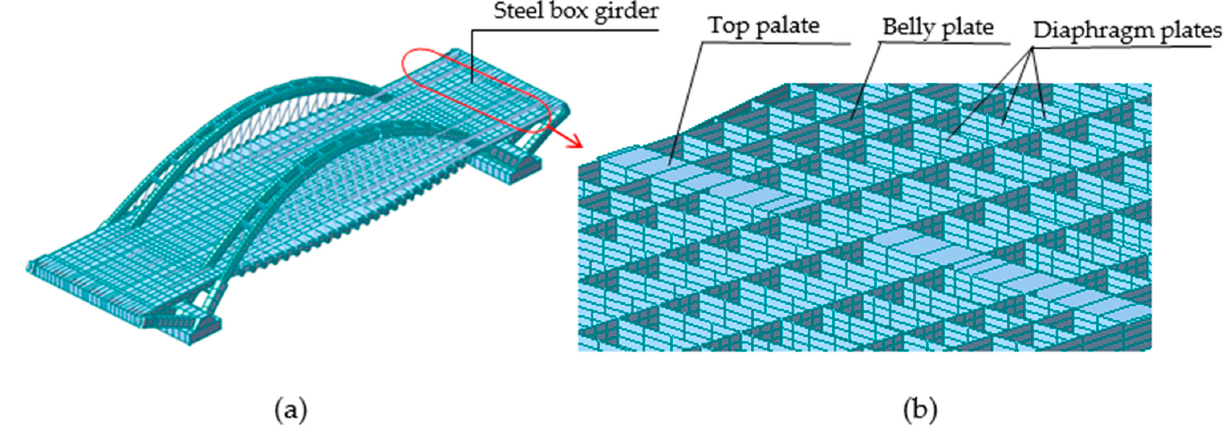
Figure 20. Finite element numerical simulation model: ( a ) 3-D view; ( b ) local view of the steel box girder discretized by 4-nodes thick-plate elements. Table 1. Mechanical properties of the materials of the bridge.